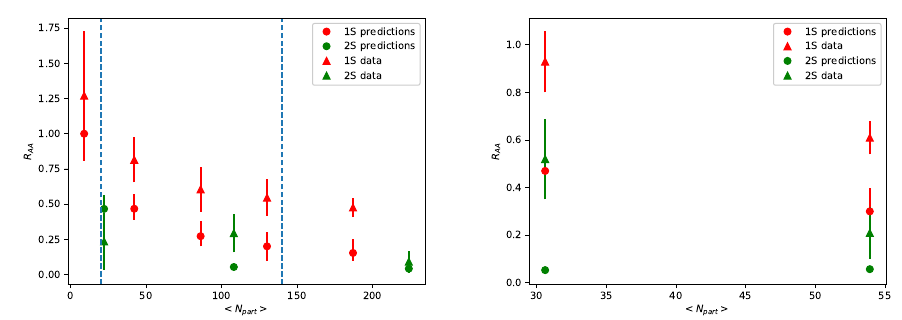
Figure 1. Suppression factor of Υ (1 S , 2 S ) as a function of centrality (given by (cid:104) N part (cid:105) ) in PbPb colli- sions. Left: comparison of our predictions with the experimental results of [23] at The vertical dashed lines highlight the window in which we expect our approximations to be valid. Right: the comparison of our prediction with the experimental results of [24] at